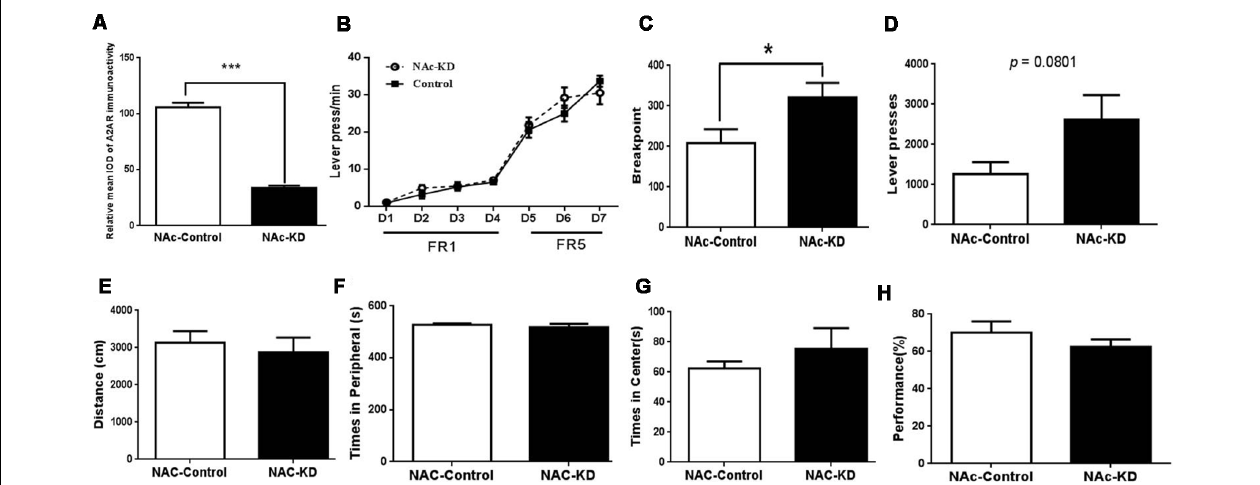
FIGURE 3 | NAc A 2A R KD-mediated facilitation of cognitive flexibility is not due to the motor activity but associated with enhanced motivation. (A) The expression level of NAc A 2A R in these new groups was validated to have a ∼ 71% decrease after AAV8-CAG-Cre-ZsGreen transfection. (B) Both groups of mice gradually increased their lever pressing rates to obtain the reward ( F ( 6,78 ) = 114.564, p < 0.01). Two-way ANOVA for repeated-measures revealed neither the main effect of A 2A R KD ( F ( 1,13 ) = 1.366, p = 0.264) nor the manipulation × training session interaction effect ( F ( 6,78 ) = 1.56, p = 0.225). (C) NAc A 2A R KD increased the breakpoint (63.2% increase, p = 0.0477) and (D) had a decreased tendency in the total number of presses (121.4% increase, p = 0.0801). (E) NAc A 2A R KD did not affect the total moving distance in the open-field test in comparison with the control ( p > 0.05, Student’s t -test). (F,G) NAc A 2A R KD did not alter the time spent in the peripheral ( F , p > 0.05) vs. central areas ( G , p > 0.05). (H) NAc A 2A R KD also did not affect the performance of spontaneous alternations in Y-maze ( H , p > 0.05). Data are presented as the mean ± SEM, ∗ p < 0.05, ∗∗∗ p <